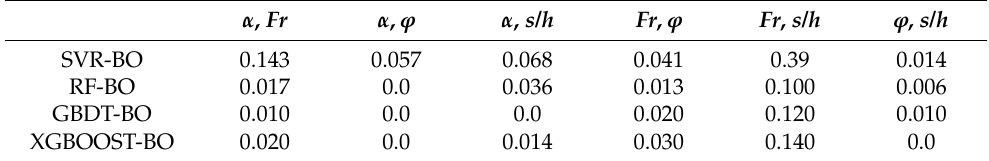
Table 7. Second-order Sobol’s indices of different ML